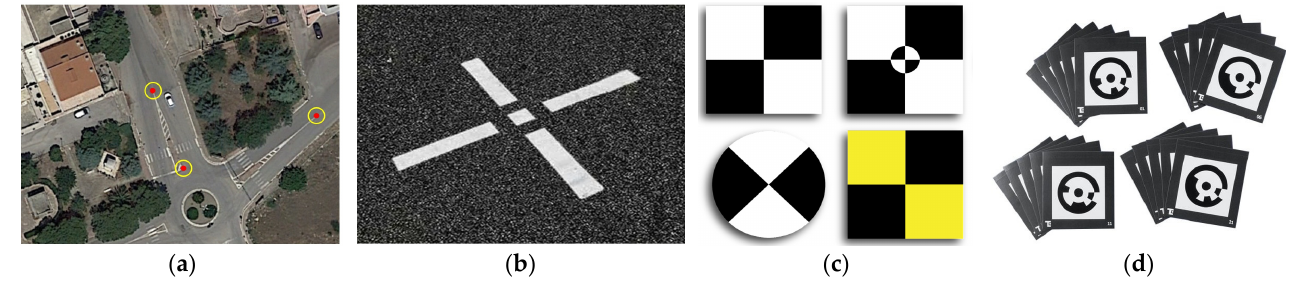
Figure 7. Ground control design: natural points ( a ), marks made with spray paint ( b ), high-contrast targets ( c ), and coded targets ( d